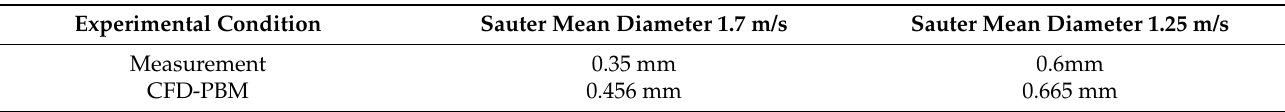
Table 2. The Sauter mean diameter as measured in the experiment and predicted by CFD model. Experimental